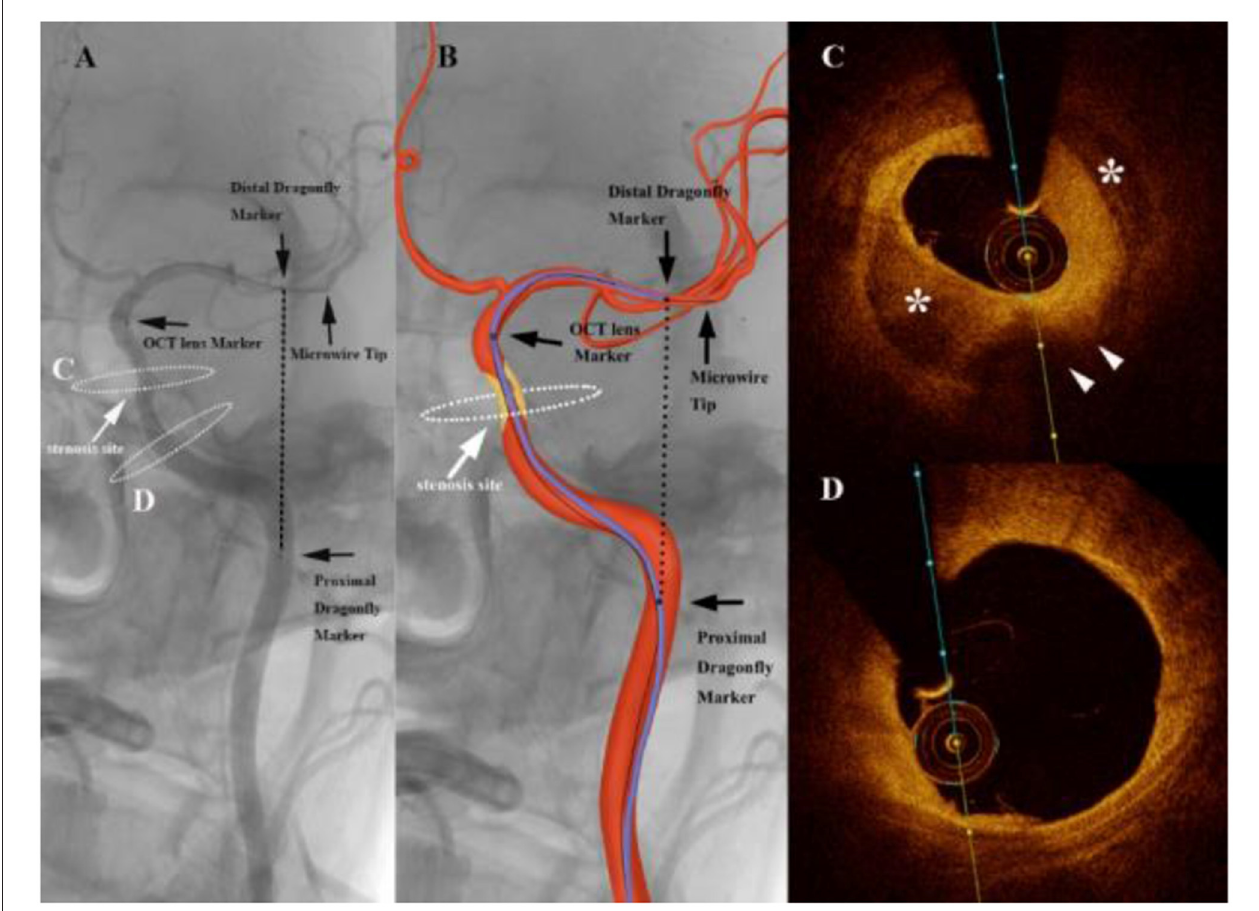
FIGURE 2 | Angiography of an intracranial atherosclerotic stenosis (ICAS) patient suffering from repeated weakness of the right upper limb with dual-antiplatelet therapy (A) showing a severe stenosis of the internal carotid artery (white arrows). The graphic of the imaging catheter and artery is overlaid in the middle panel (B) . The markers of the Dragonfly Duo imaging catheter and the optical coherence tomography (OCT) lens are noted in the left and middle panels (black arrows). The black dashed line represents the linear length between the first and third markers. White dashed ellipses on the left panel correspond to the cross section of the OCT acquisition. (C) Frequency-domain optical coherence tomography (FD-OCT) imaging demonstrated the atherosclerotic plaque (white arrowheads) with calcification (*), which imparted the severe stenosis. (D) 10mm proximal to the cross section A, the artery wall was almost